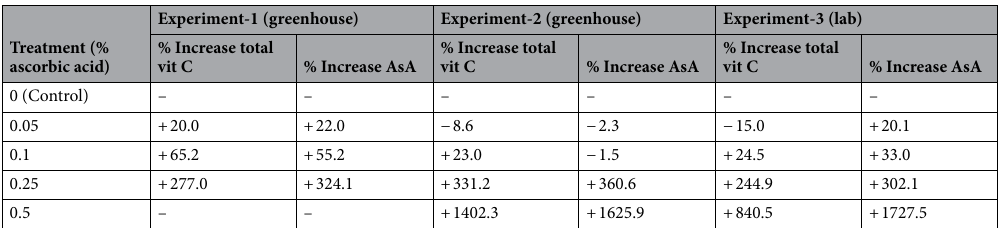
Table 1. Average percent change of total Vit C and ascorbic acid (AsA) in each treatment treated with different concentrations of ascorbic acid over 3 different experiments. Significant differences ( p ≤ 0.05) among treatments are indicated by different lowercase letters within the experiment. (n = 5). FW fresh weight.